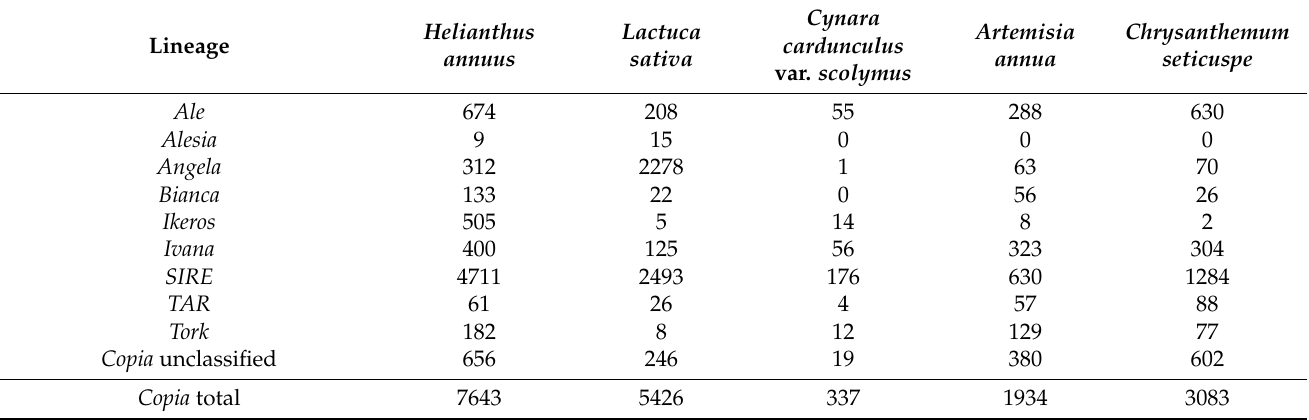
Table 4. Number of LTR-REs identified for each genome, specified for each superfamily and lineage. LTR-RE = long terminal repeat